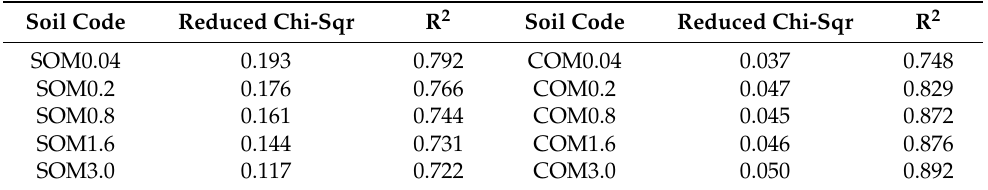
Table 5. Reduced Chi-Sqr and R 2 of the measured value and the Campbell model simulation value for soils with different organic matter